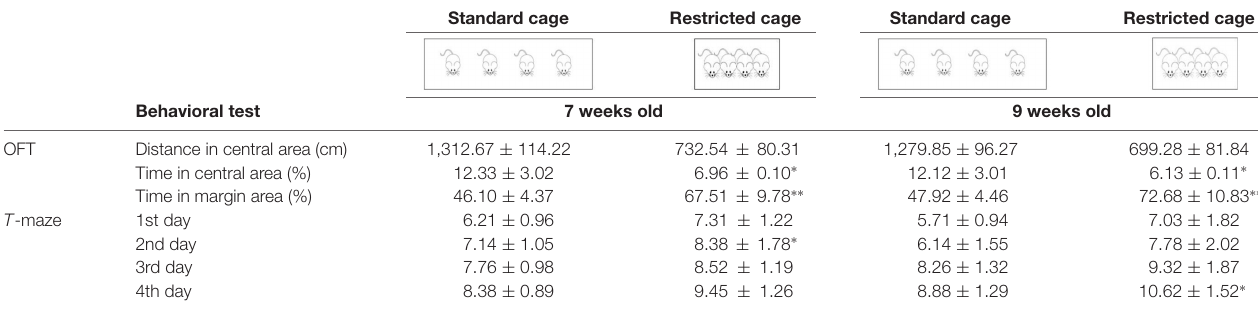
TABLE 2 | The results of OFT and T -maze tests. Standard cage Restricted cage Standard cage Restricted cage